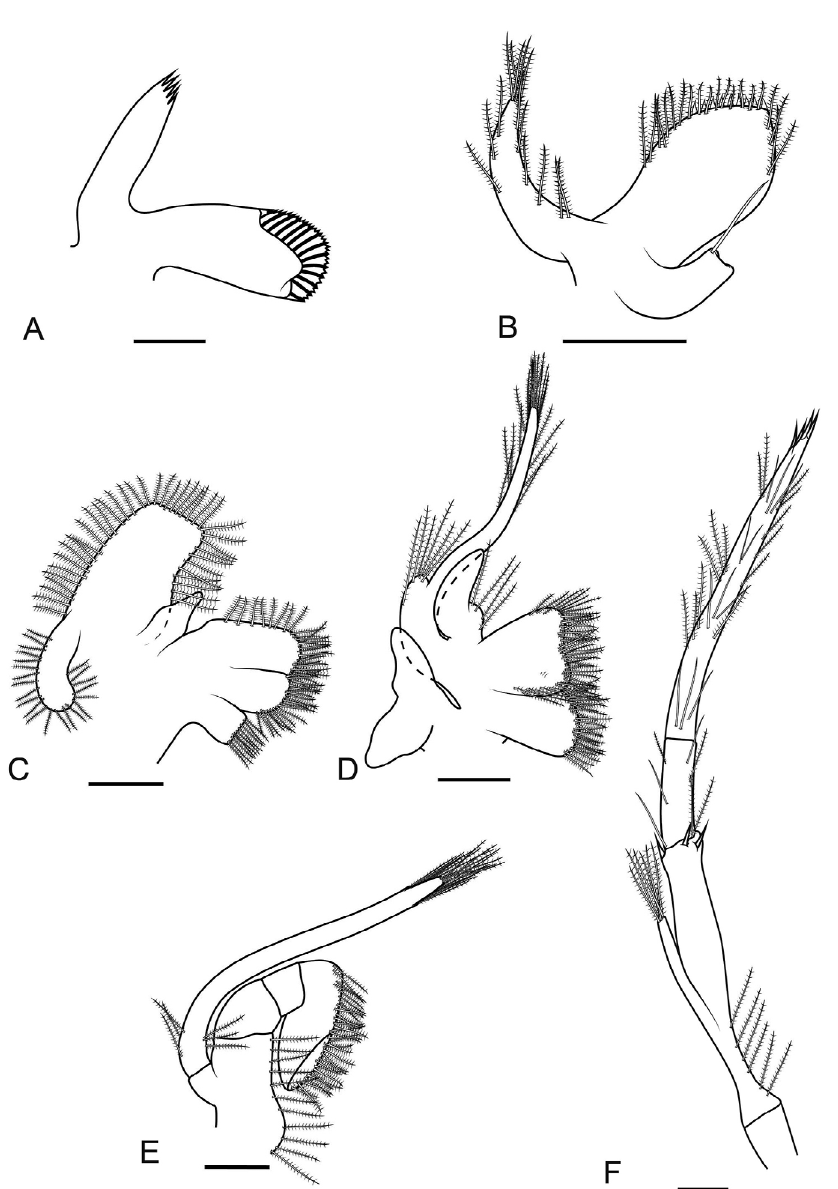
Figure 3. Thor manningi Chace, 1972. Brazil, São Paulo. Female (CCDB 2593). A , Right mandible, ventral view; B , right maxillule, ventral view; C , left maxilla, ventral view; D , left first maxilliped, ventral view; E , left second maxilliped, ventral view; F , left third maxilliped, ventral view. Scale bars: 0.25